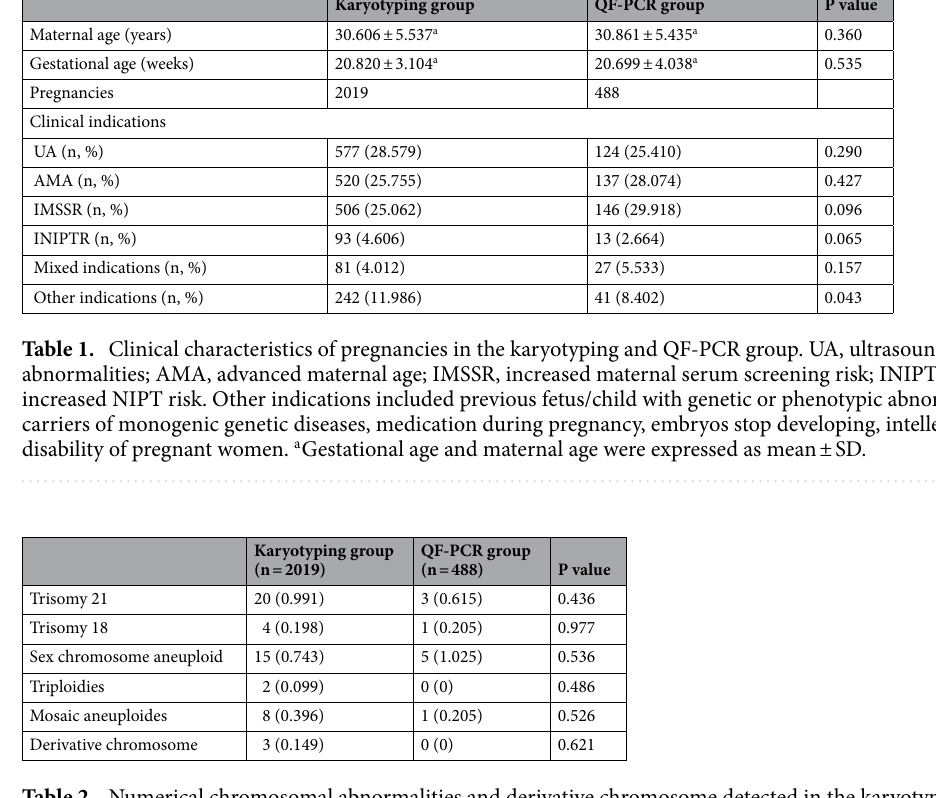
Table 2. Numerical chromosomal abnormalities and derivative chromosome detected in the karyotyping and QF-PCR group. Case numbers and percentages for these numbers were listed in the table.